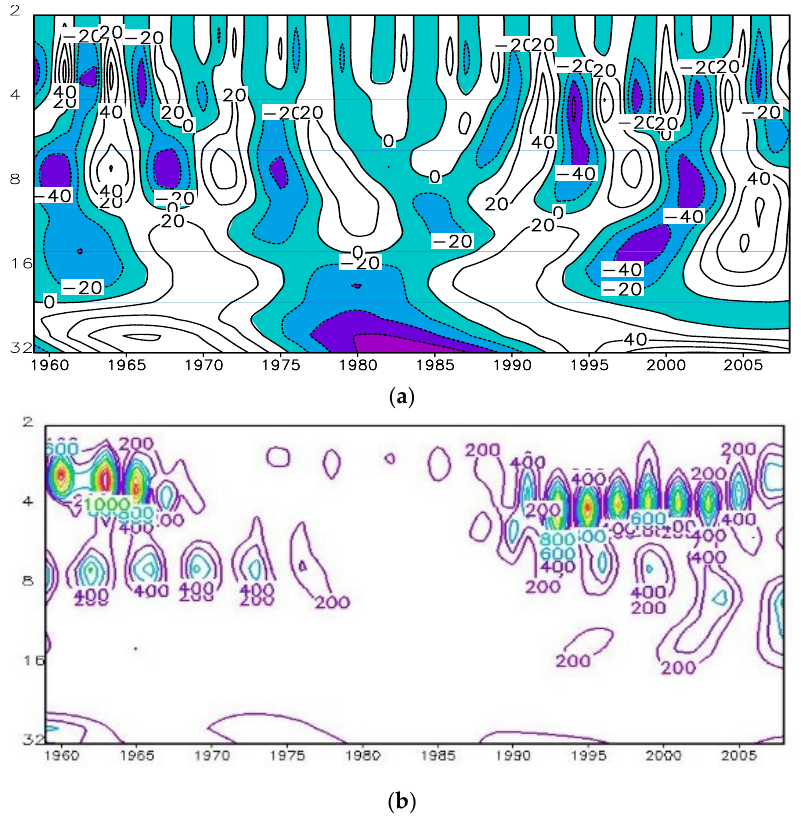
Figure 3. Wavelet analysis of rainfall cycle in PFSSC ( a ) and energy diagram ( b ).